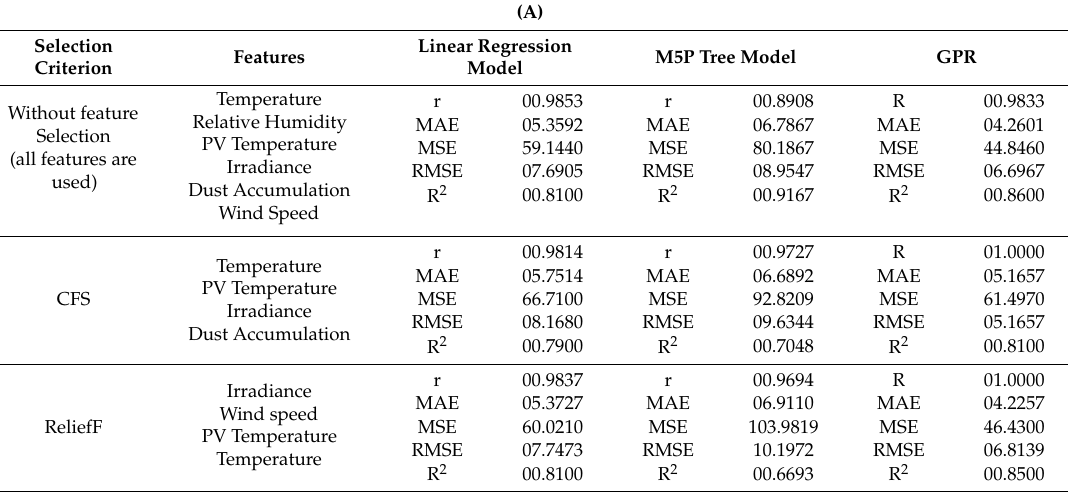
Table 6. (A) Performance comparison between the various regression techniques (validation phase). (B) Performance comparison between the various regression techniques (testing